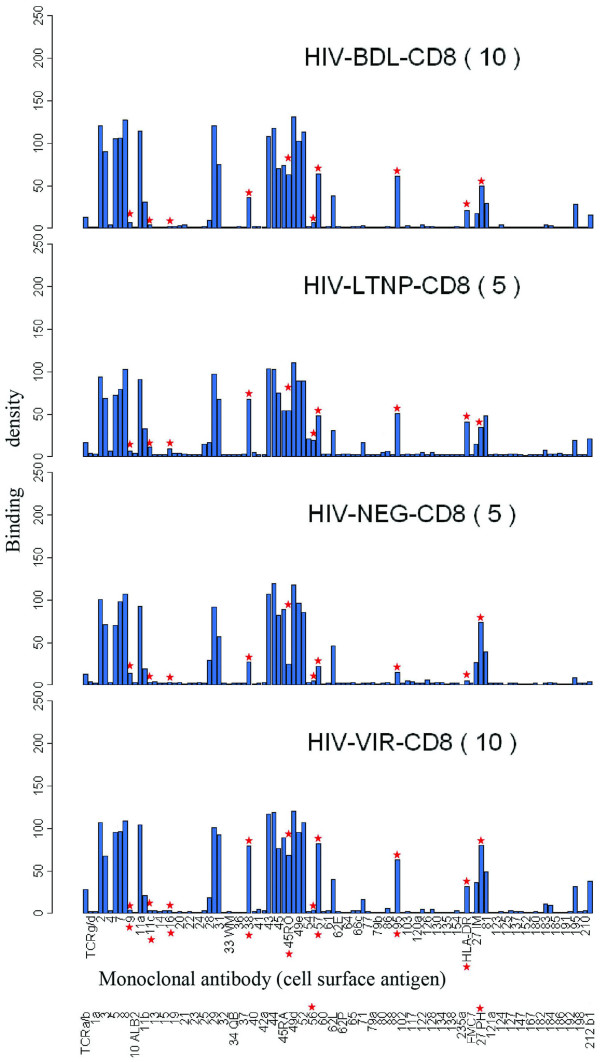
Antibody response charts of CD8+ T cells. The bar charts represent the average immunophenotypes, or signatures, for each of the disease categories. Asterisks show the antigens which were significantly up-or down-regulated in paired comparisons of the disease groups. Labeling on the x-axis refers to monoclonal antibodies and their specificities against the corresponding antigens and the y-axis the binding densities.